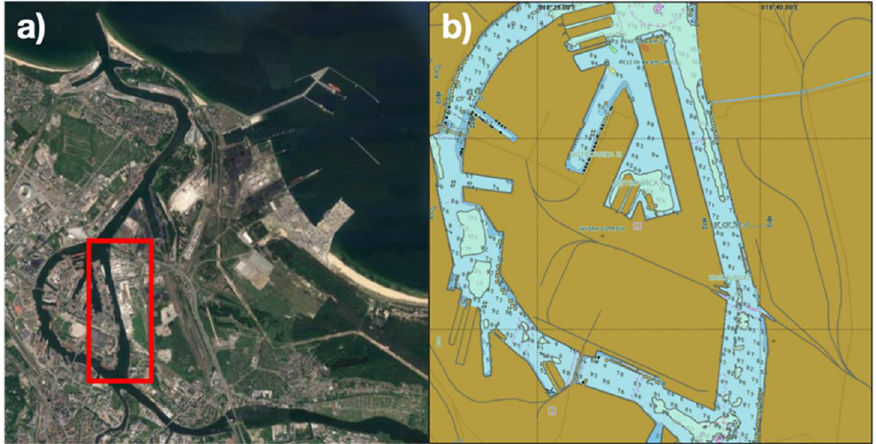
Figure 5. Area accepted for research: The Kashubian Canal (( a )—https://www.google.pl/maps, access date: 20 May 2021; ( b )—NT Pro 5000 simulator software).